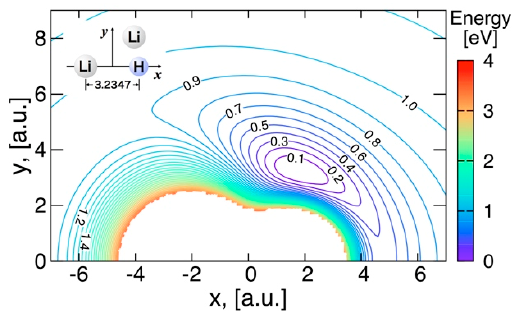
Figure 7. Energy contours when the Li atom moves around a fixed Li − H distance with r(Li − H) = 3.235 a.u. The center of mass of LiH is at the origin. The energy contours are equally spaced by 0.1 eV, starting at the ground state minimum.